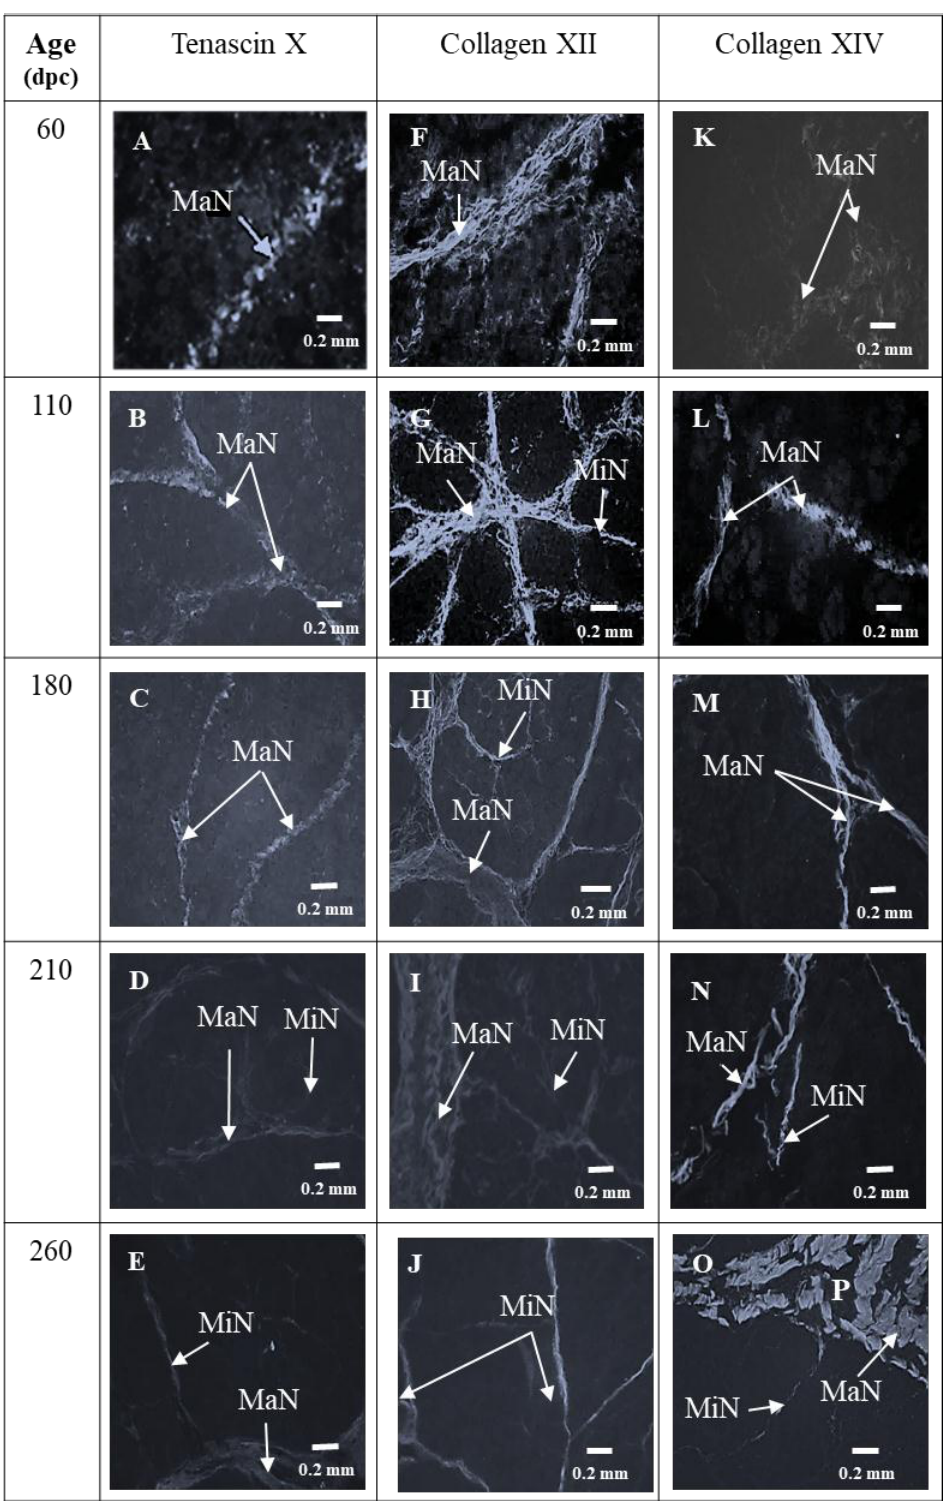
Figure 4. Mmunohistochemical labelling with antibodies against tenascin-X ( A , B , C , D , E ), collagen XII ( F , G , H , I , J ), collagen XIV ( K , L , M , N , O ) of transverse sections of foetal Semitendinosus muscle at 60, 110, 180, 210 and 260 days post-conception (dpc). (Major (MaN) and minor (MiN) networks of perimysium).